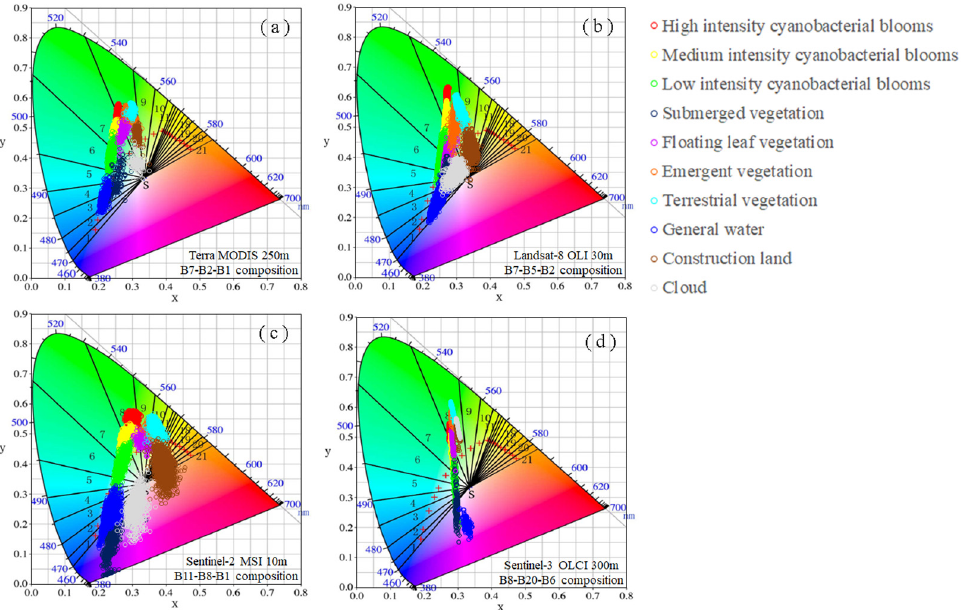
Figure 8. Comparison of the results of chromaticity coordinates of P-FUI calculation based on ( a ) MODIS, ( b ) OLI, ( c ) MSI, and ( d ) OLCI sensors.